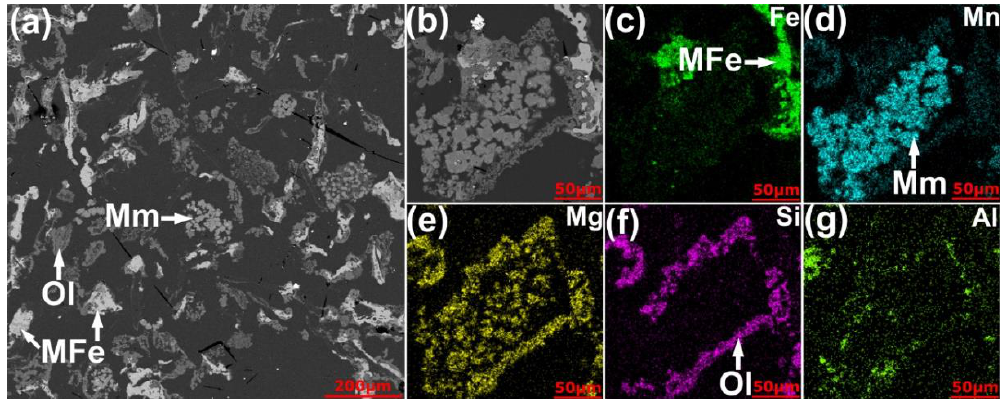
Figure 13. BSE image ( a ) of the reduced product (after water-leaching) with 20 wt% CaCl 2 and 40 wt% MgCl 2 addition at low magnification, and BSE image ( b ) of an individual reduced ore particle with its elemental mapping graphs ( c – g ) MFe: metallic Fe; Mm: (MgO) x (MnO) 1 − x ; Ol: olivine-type Mg 2 − x Mn x SiO 4 ).